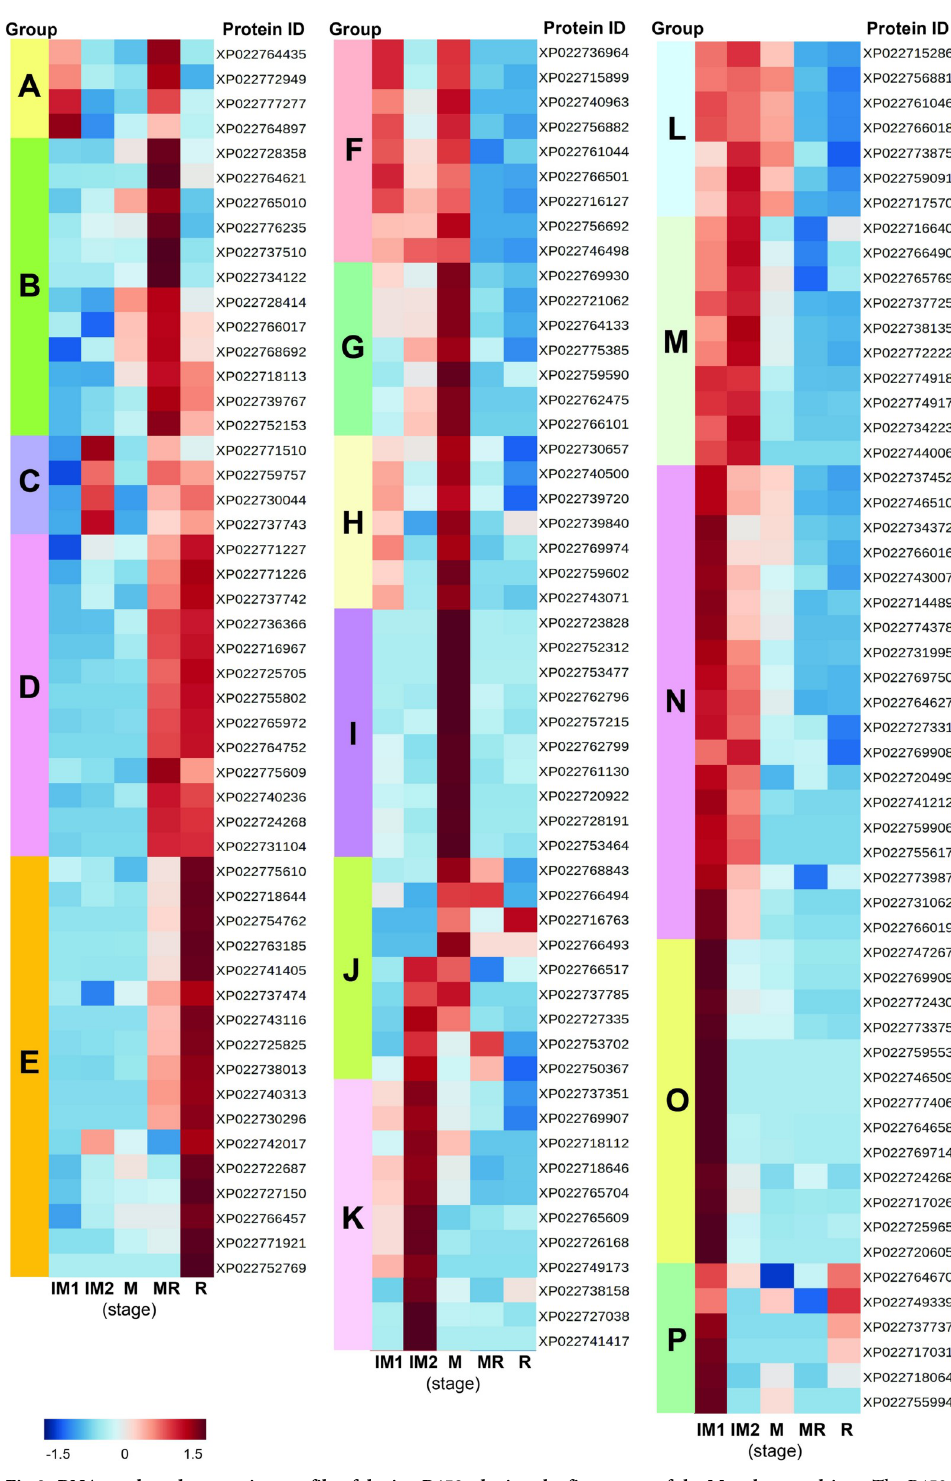
PLOS ONE | https://doi.org/10.1371/journal.pone.0260665 November30,